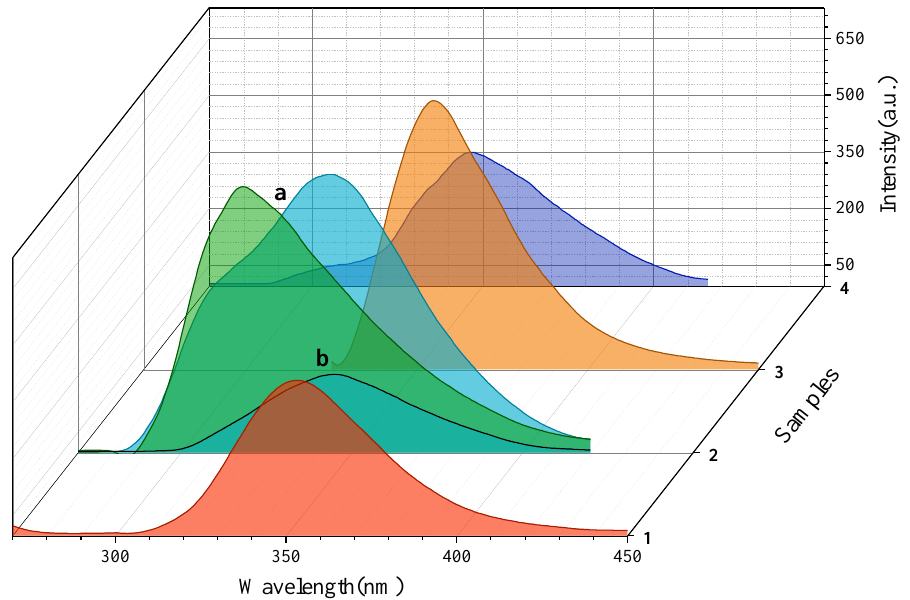
Figure 10. Emission spectra in MeOH at 298 K of the samples at concentrations of 1.70 × 10 −9 M ( 1 ); ( a ) 1.07 × 10 −7 M and ( b ) 1.08 × 10 −8 M ( 2 ); 1.04 × 10 −7 M ( 3 ); and 1.01 × 10 −7 M ( 4 ). Color codes: red ( 1 ); light green and turquoise ( 2 ); orange ( 3 ); blue ( 4 ).